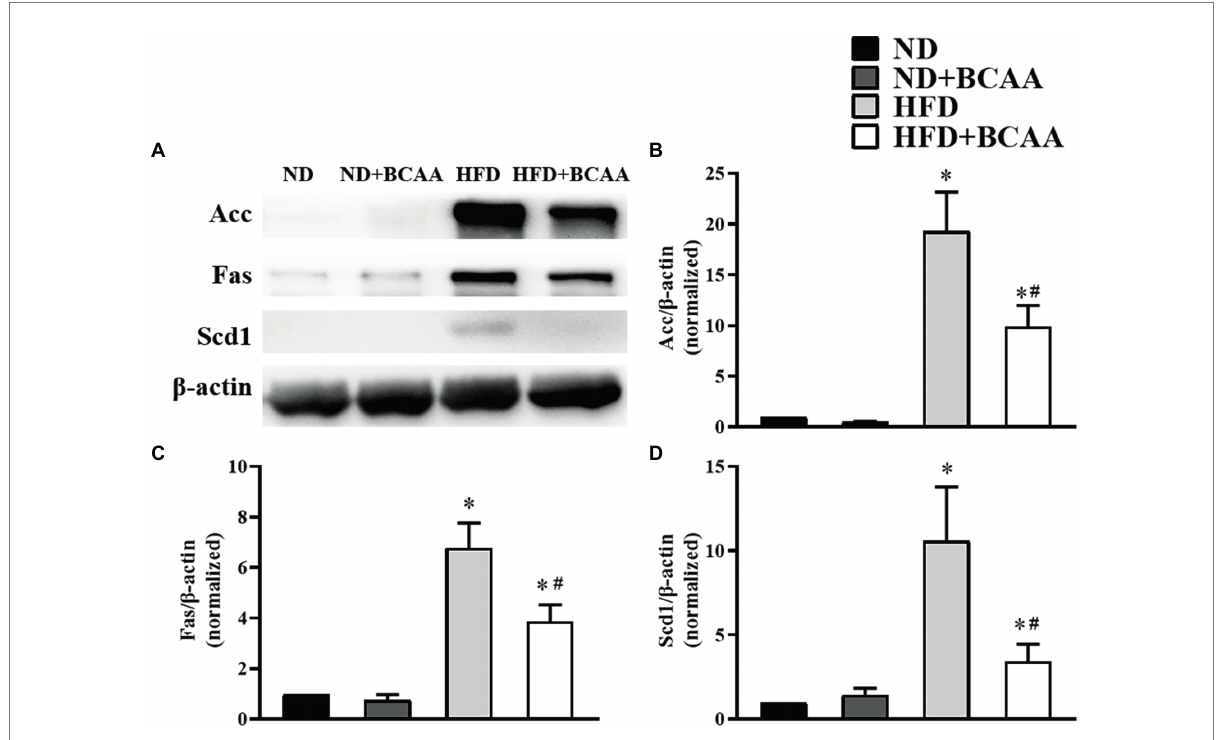
FIGURE 4 Effect of BCAAs supplementation on the hepatic fatty acid synthesis in HFD-fed mice. (A) The protein expression of acetyl-CoA carboxylase (Acc), fatty acid synthase (Fas), and stearoyl-CoA desaturase 1 (Scd1) in the liver. The relative quantitative data for (B) Acc, (C) Fas, and (D) Scd1 as indicated. The densitometries were normalized to β -actin. The data are presented as the mean ± SEM ( n = 6). * p < 0.05 vs. the ND group; # p < 0.05 vs. the HFD